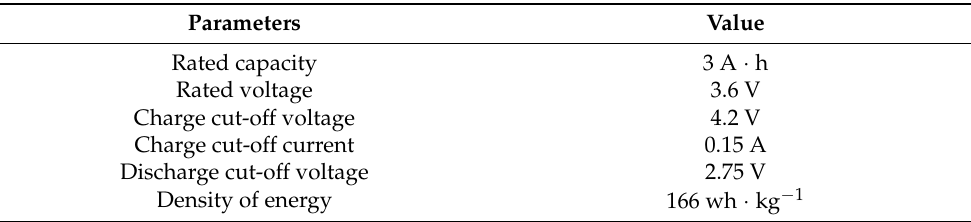
Table 1. Lithium-ion battery parameters.